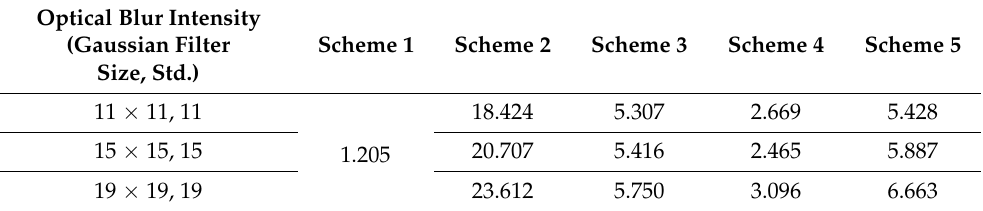
Table 8. Finger-vein recognition error (EER) comparison according to motion and optical blur ap- plication in PolyU-DB (unit: %).